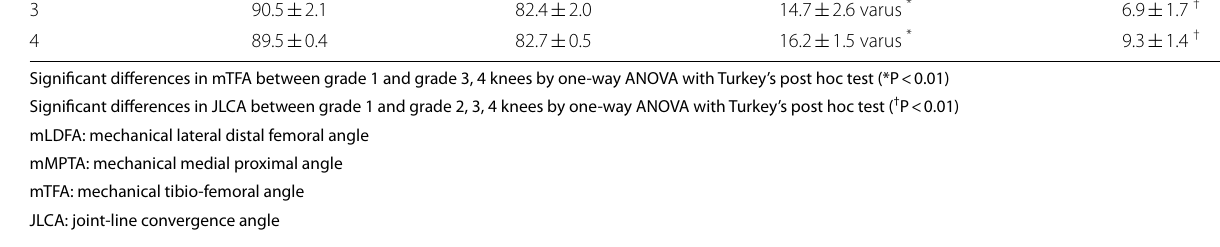
Table 3 Relationships between preoperative knee parameters and Ahlbäck grade